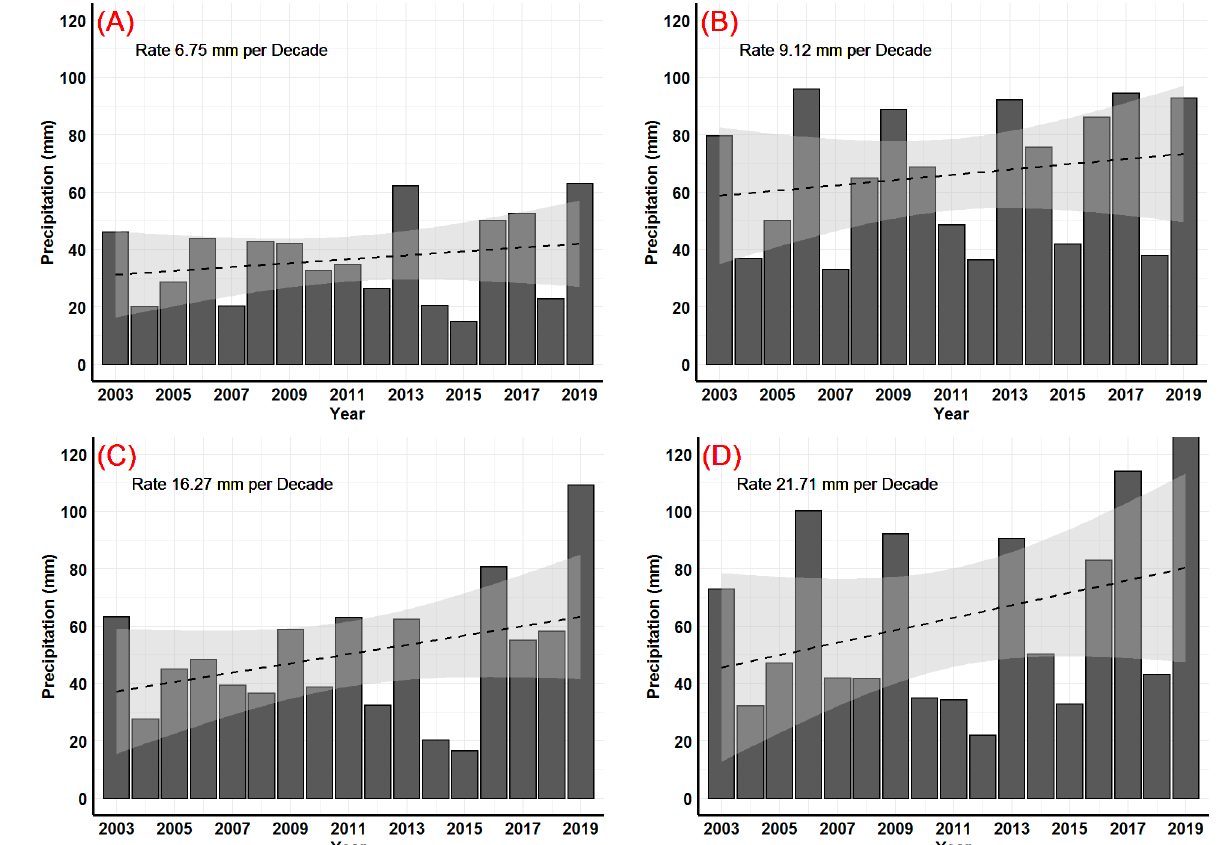
Figure 3. Areal average total annual rainfall and its annual trend with a 95% confidence interval (gray) for ( A ) CMORPH, ( B ) IMERG, ( C ) PERSIANN, and ( D ) rain gauges.